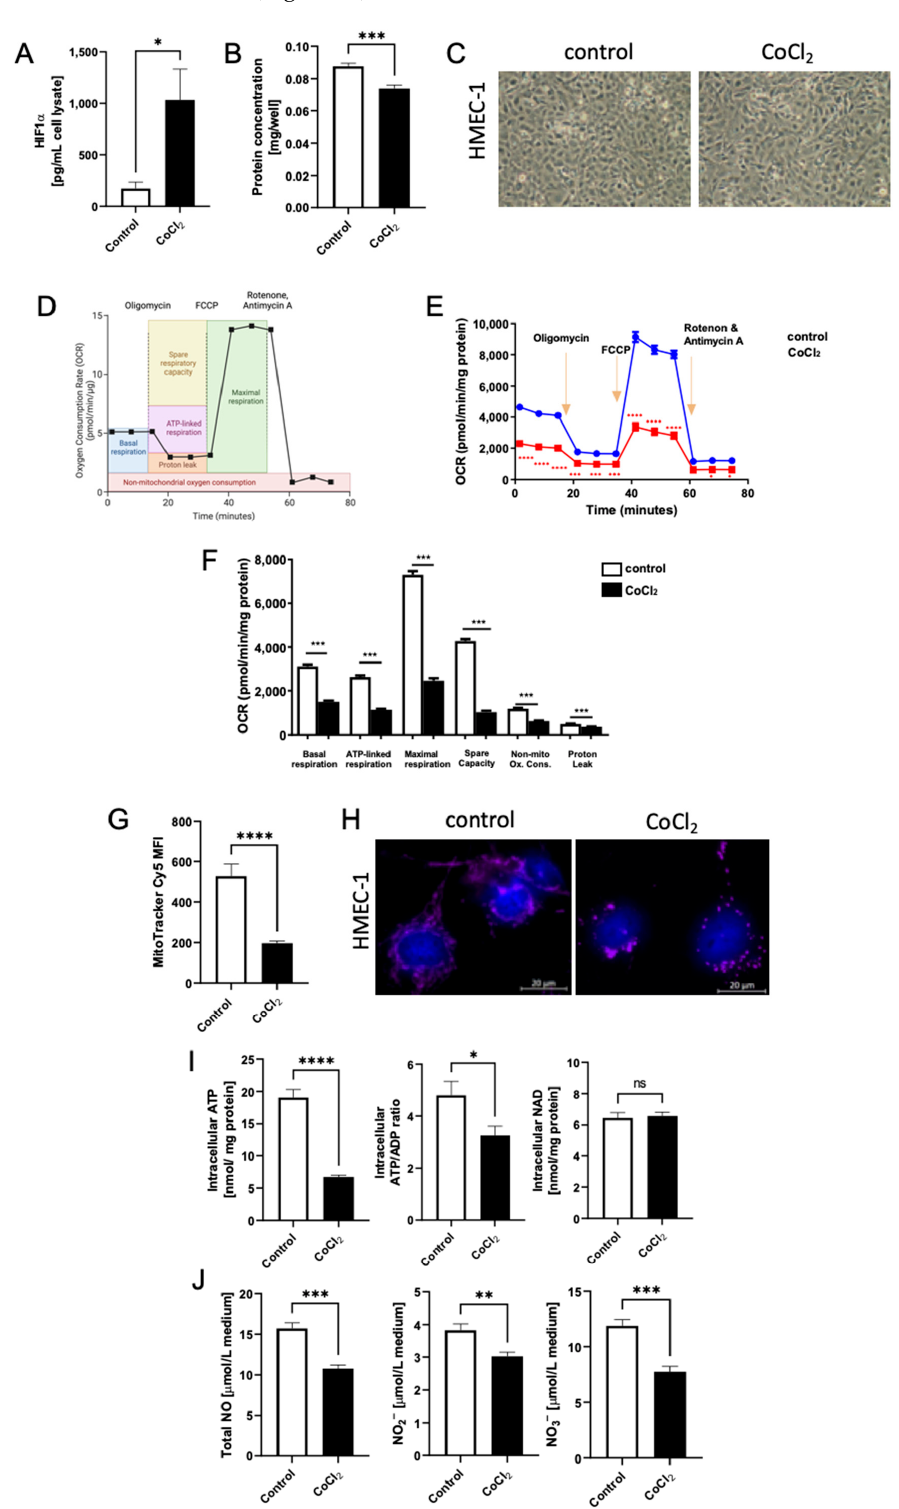
Figure 4. CoCl 2 -mimicked hypoxia depleted intracellular ATP concentration via decreased oxida- tive phosphorylation that was related to disrupted endothelial function in human microvascular endothelial cells (HMEC-1s). ( A ). HIF-1 α levels were determined in HMEC-1 cell lysate in